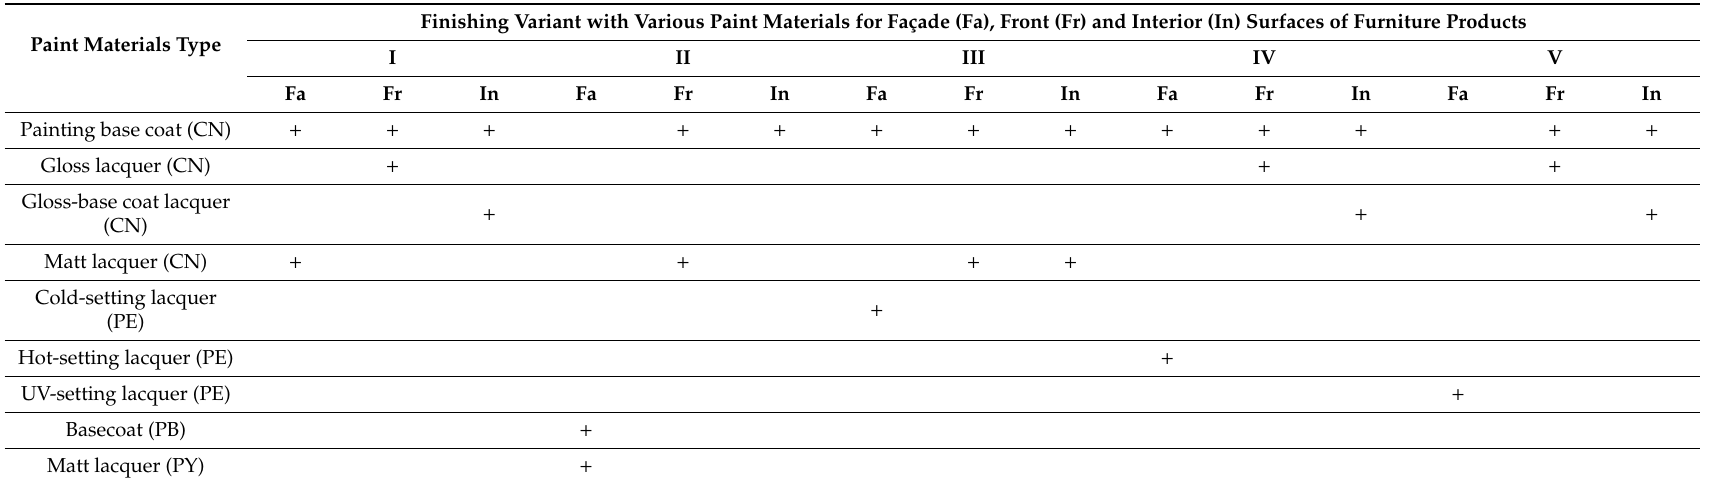
Table 1. Finishing options for the facade, the front and inner surfaces of the parts and components of furniture products with various paints and